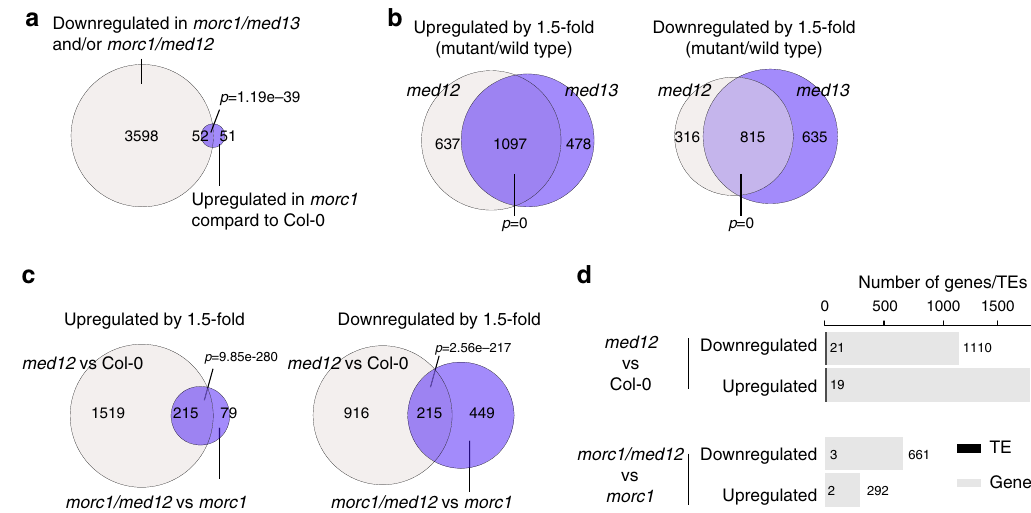
Fig. 2 Characterization of med12/13 differentially regulated genes. a Venn diagram showing the overlap between genes that are downregulated in morc1/ med12 and/or morc1/med13 mutants and those that are upregulated in morc1 background compared to wild-type (Col-0). Size is proportional to the number of genes de fi ned for each group. p value indicates a statistical signi fi cance of the overlap (hypergeometric test, one sided). b Venn diagram showing the overlap between genes that are upregulated (left) and downregulated (right) in med12 and med13 compared to wild-type plants (fold change >1.5, FDR < 0.05). Size is proportional to the number of genes de fi ned for each group. p value indicates a statistical signi fi cance of the overlap (hypergeometric test, one-sided). c Venn diagram showing the overlaps of med12 upregulated (left) and downregulated (right) genes between wild-type and morc1 background (fold change >1.5, FDR < 0.05). Data display conventions as in b . p value indicates a statistical signi fi cance of the overlap (hypergeometric test, one sided). d Bar chart showing the number of genes (gray) and TEs (black) that are differentially regulated by MED12 in wild-type (upper) and morc1 (lower) backgrounds. Source data are provided as a Source data fi